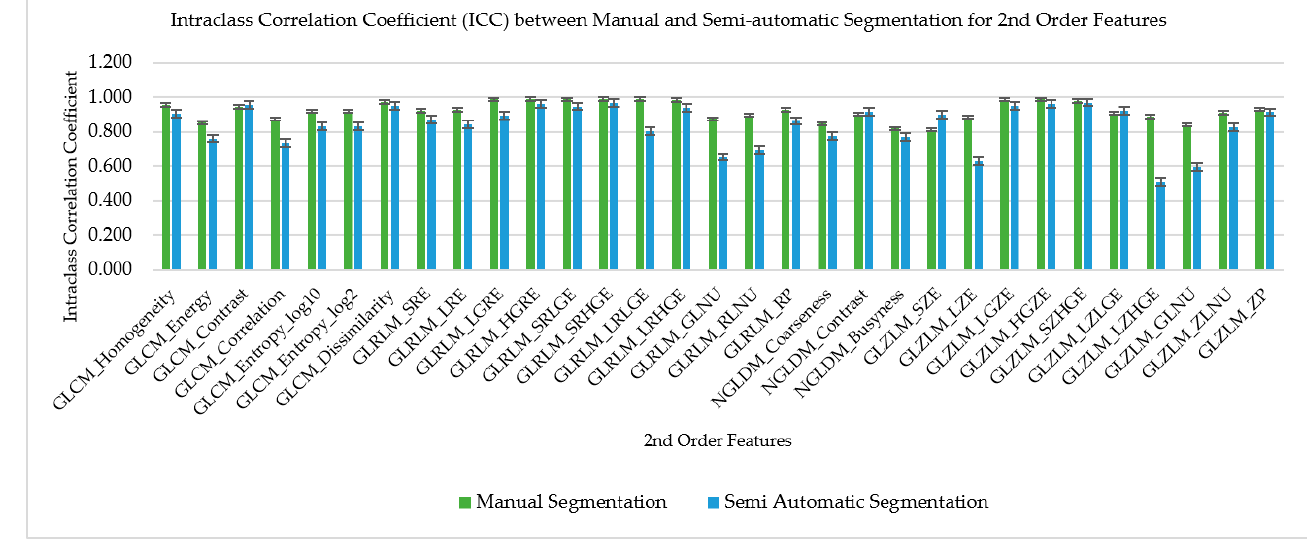
Figure 9. Intraclass Correlation Coefficient (inter-CC) between manual and semi-automatic segmen- tation for 2nd order features to compare its repeatability.